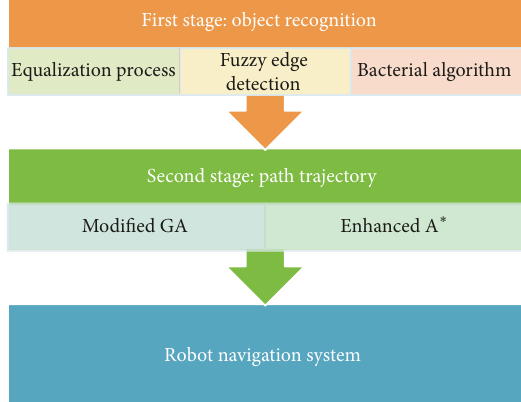
Figure 1: The proposed computer vision